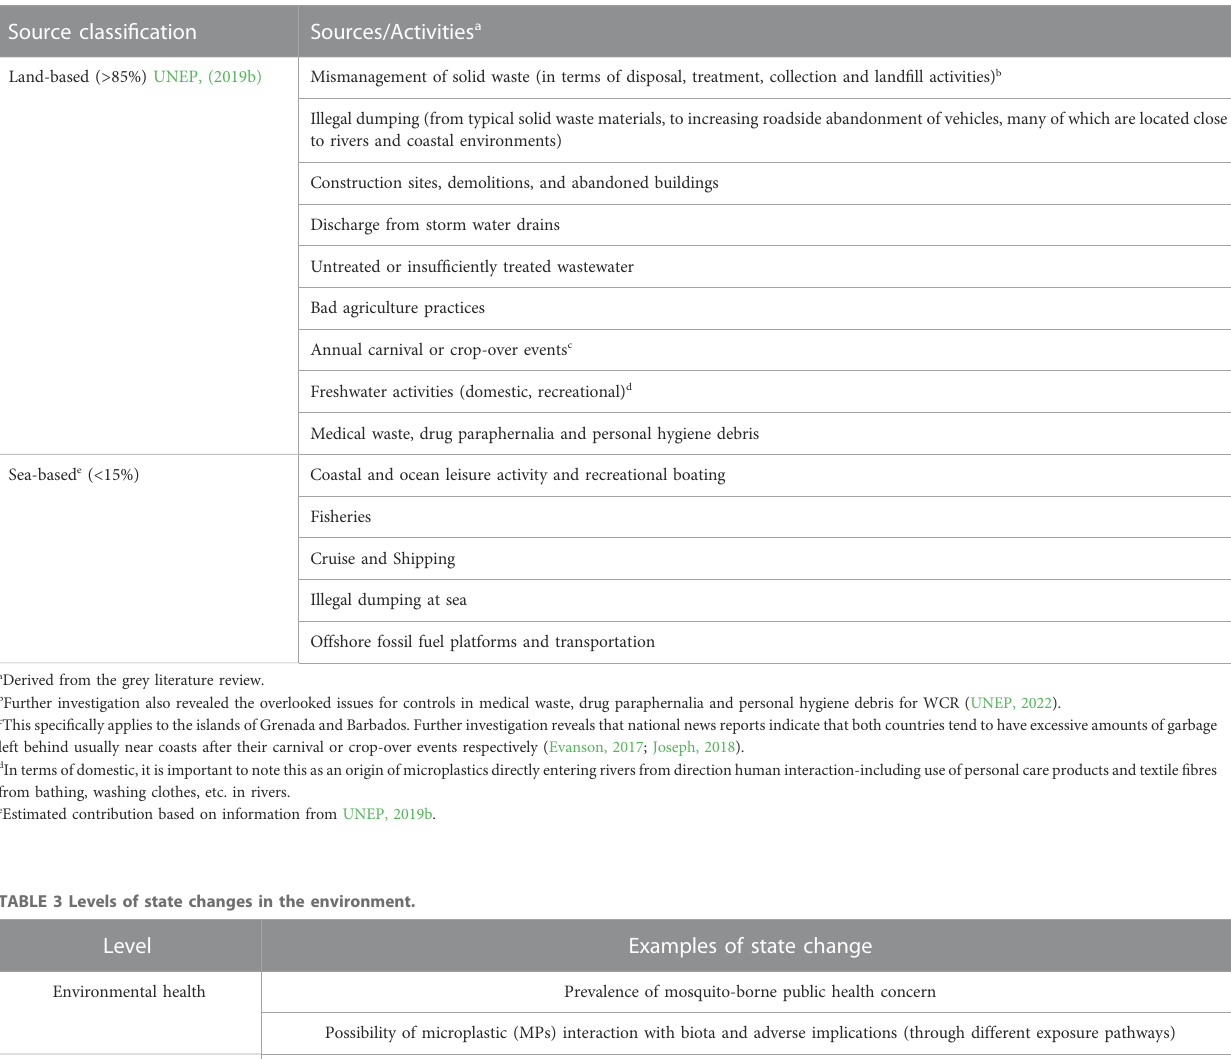
TABLE 2 Main sources of marine litter.